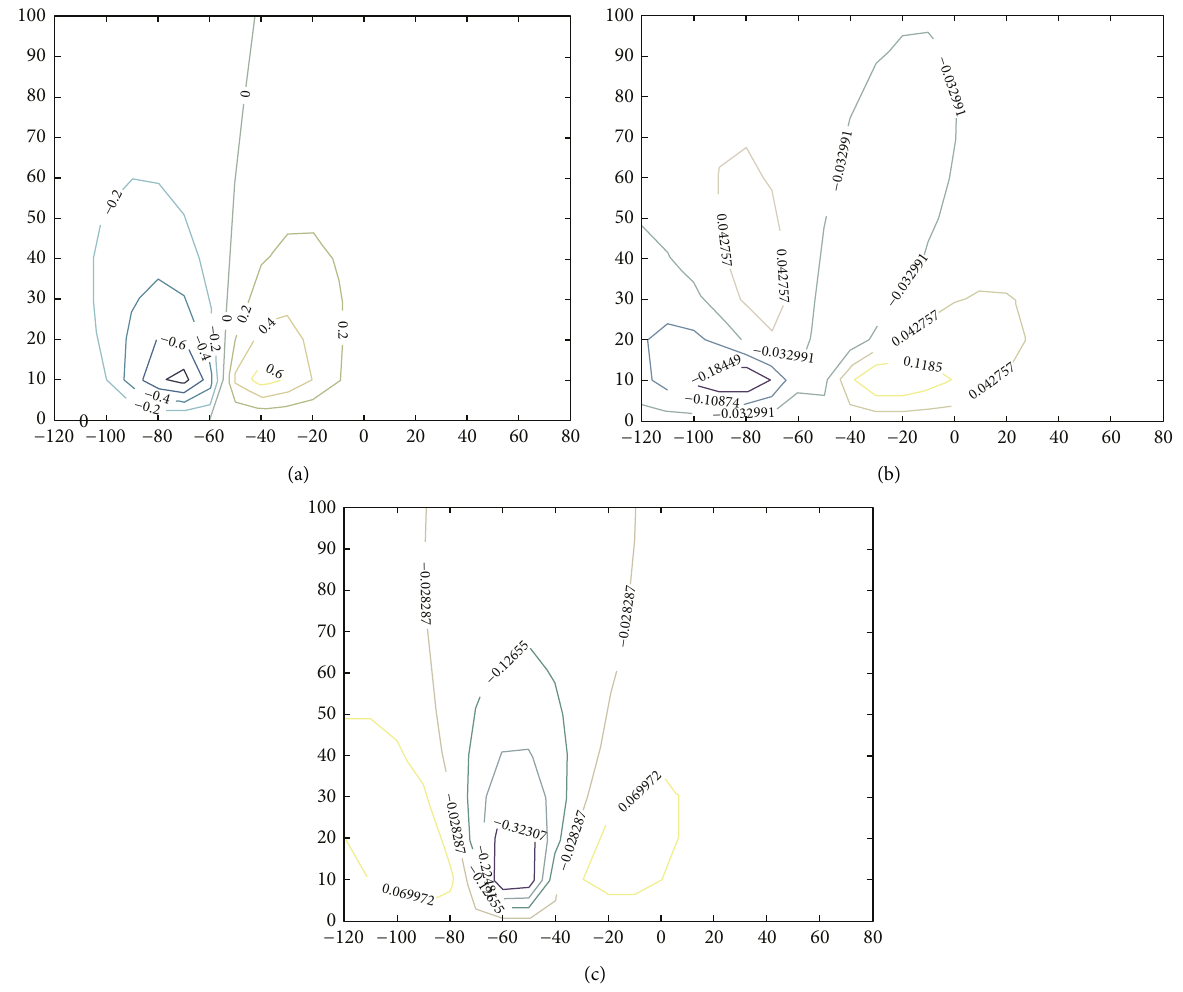
Figure 6: Contours of overburden stress increment. (a) Contour plot of vertical stress increment ratio. (b) Contour map of horizontal stress increment ratio. (c) Shear stress increment ratio cloud graph. (The abscissa is the dip direction of the working face, the ordinate is the height, and − 60m is the position of the working face).